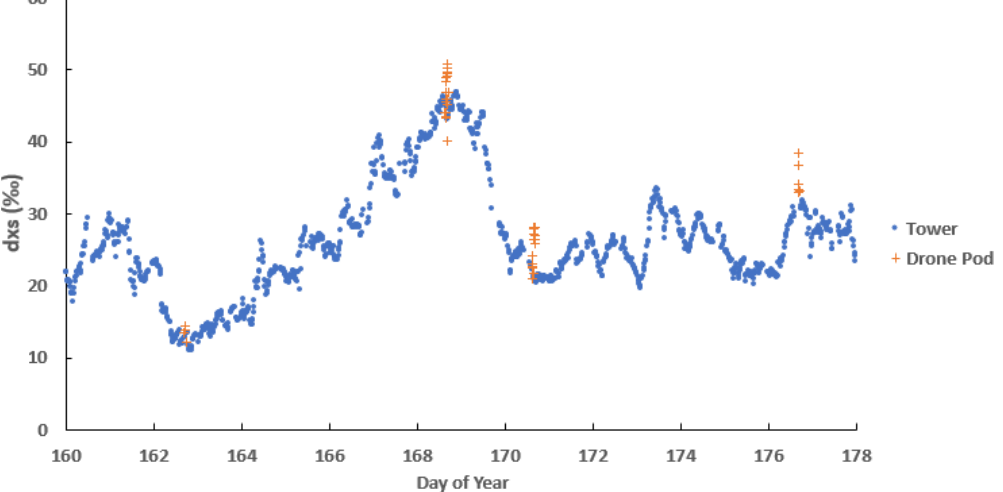
Figure 5. Comparison in second-order parameter dxs between the tower setup present at the EastGRIP camp in 2019 and 2m pod intercom- parison measurements. Drone pod measurements on 163DOY (day of year) and 176DOY correspond to flask measurements taken at 2m during a flight mission. All measurements from both tower and UAV are tied to the same isotopic water standards listed in Table